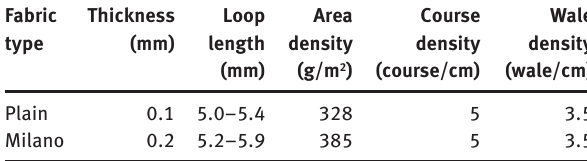
Table 3 Some physical properties of knitted fabrics.